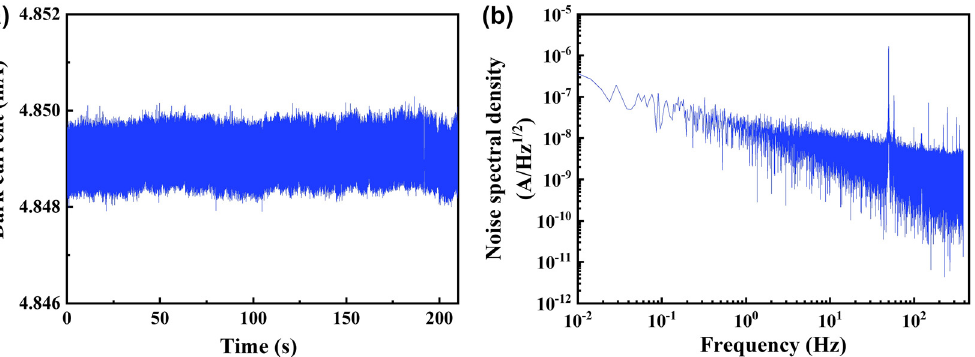
Figure 7: The NEP test results. (a)ThedarkcurrentwaveformofPPIDatabiasvoltageof0.3Vandthesamplingfrequencyof1.95KHz.(b)Analysisofnoisespectraldensityof PPID based on the dark current waveform measured in